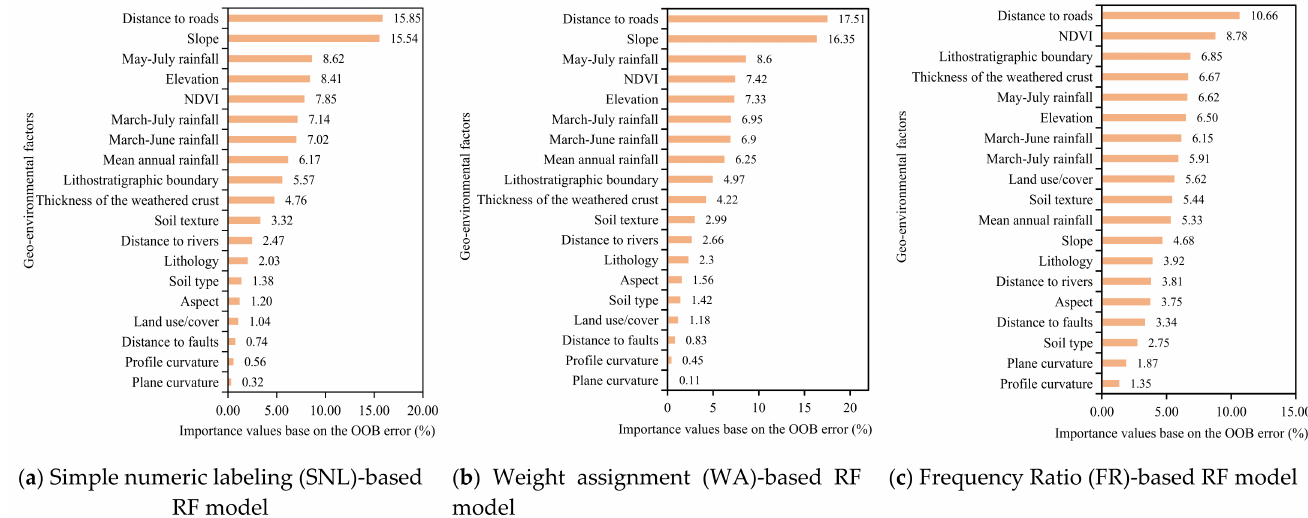
Figure 11. Importance (%) of the geo-environmental factors in landslide events from different random forest (RF)